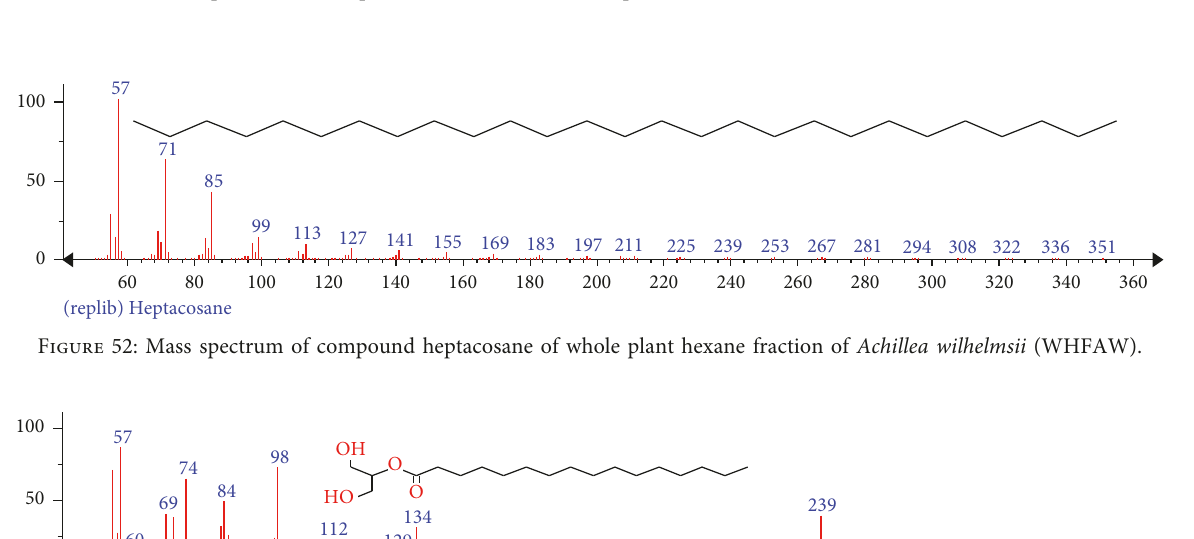
1-Docosene60 80 (replib) Figure 51: Mass spectrum of compound 1-docosene of whole plant hexane fraction of Achillea wilhelmsii (WHFAW).